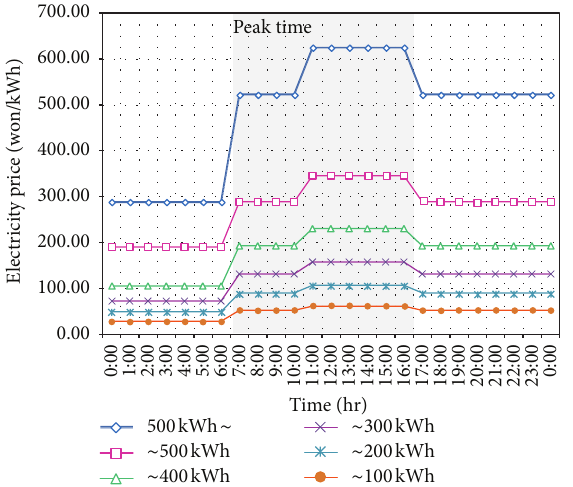
Figure 3: Real-time pricing system used in Jeju.